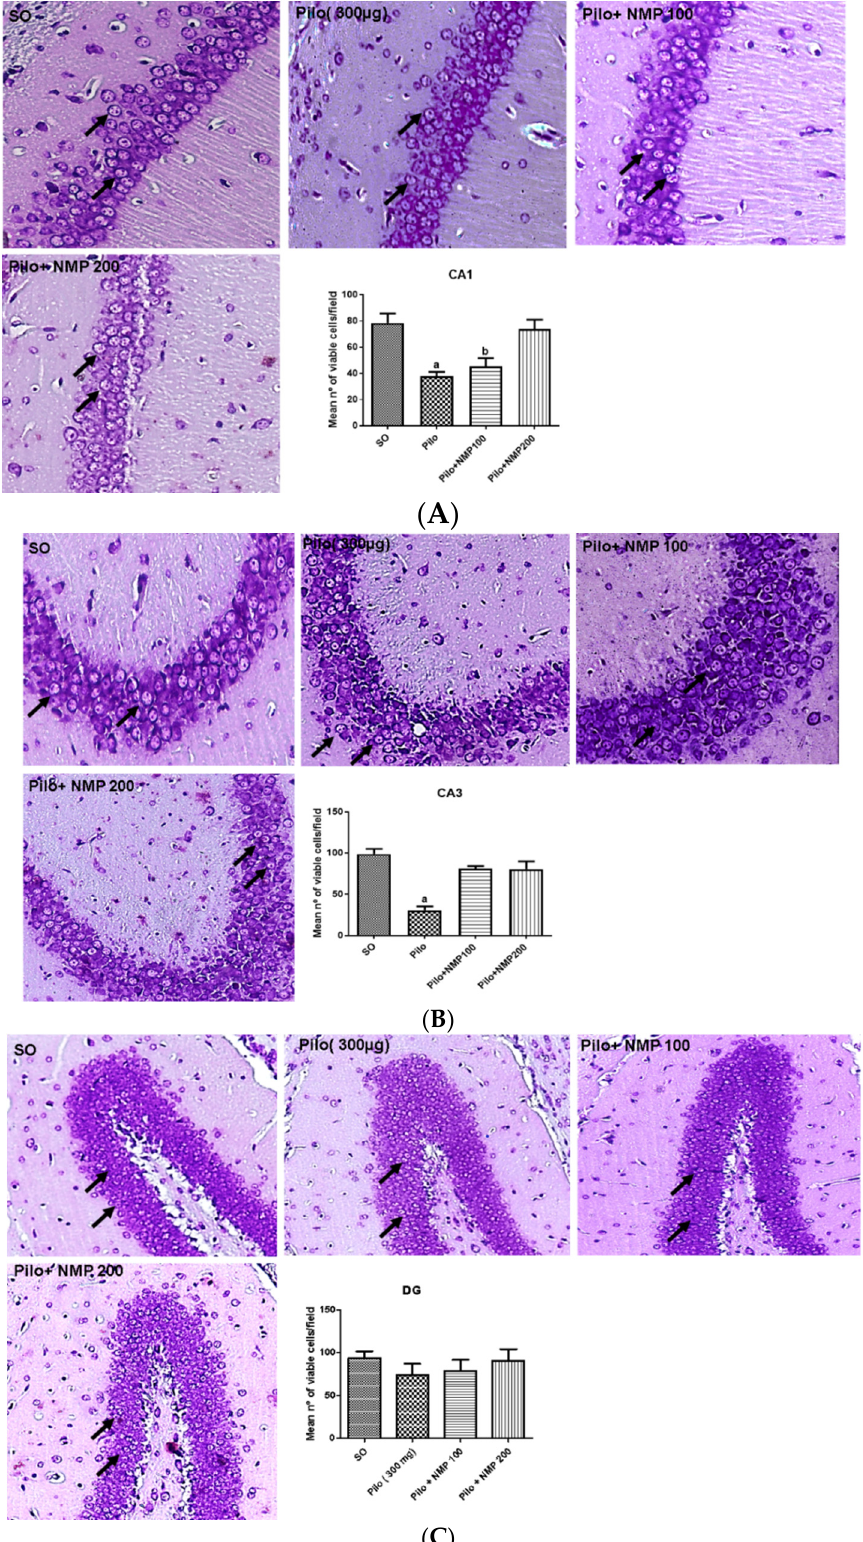
Figure 3. Representative photomicrographs (100 magnification) of the hippocampal cornu Ammonis (CA) subfields CA1 ( A ), CA3 ( B ), and ( C ) dentate gyrus (DG), showing that the N -methyl-(2S,4R)-trans-4-hydroxy- L -proline-rich fraction (NMP) increased the number of hippocampal viable cells in mice subjected to the intracerebroventricular (icv) injection of pilocarpine (Pilo). The animals received Pilo (300 µg/1 µL, icv) and, 24 h after, were treated with NMP (100 or 200 mg/kg per os , po ), for 15 days. The sham-operated (SO) group received the vehicle, distilled water po . After the behavioral